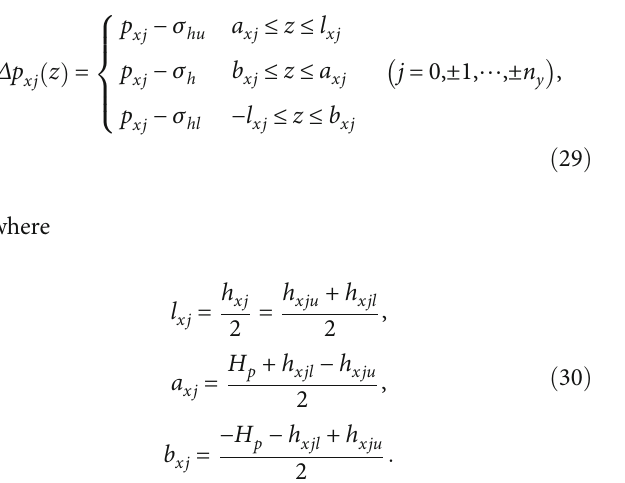
q ffiffiffiffiffiffiffiffiffiffiffiffiffiffiffi l 2 − a 2 xj q ffiffiffiffiffiffiffiffiffiffiffiffiffiffiffi l 2 − b 2 xj